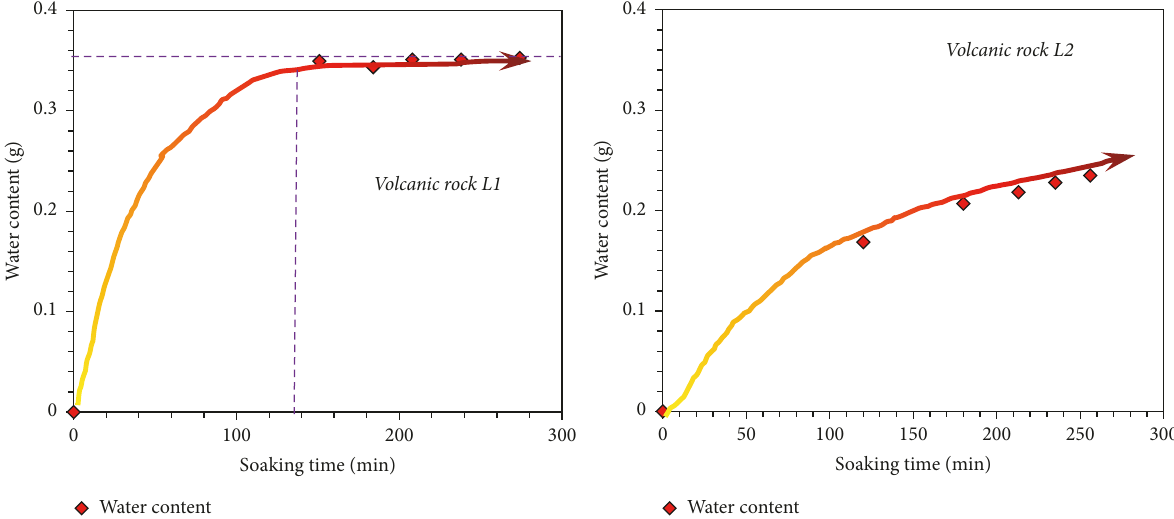
Water content Figure 5: The water content as a function of soaking time: volcanic rocks L1 and L2. During imbibition the samples were soaked into the distilled liquid entirely. The trend curve represents the direction of water content change.